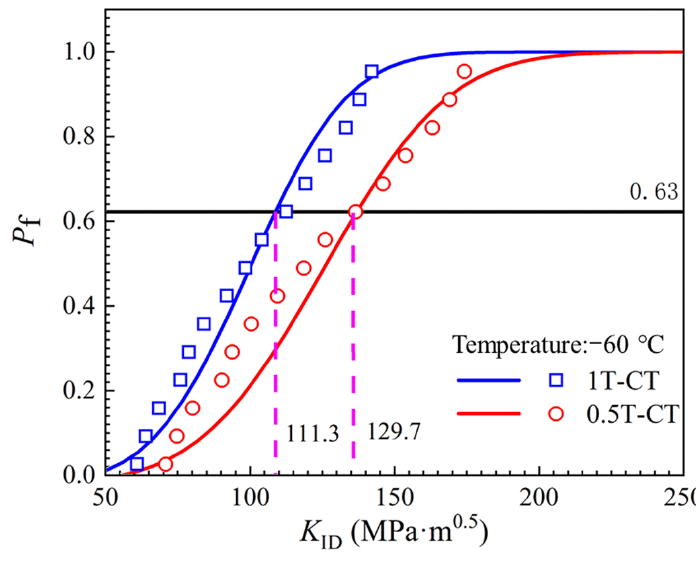
Figure 16. Cumulative failure probability distribution of fracture toughness of 0.5T-CT sample and 1T-CT sample.